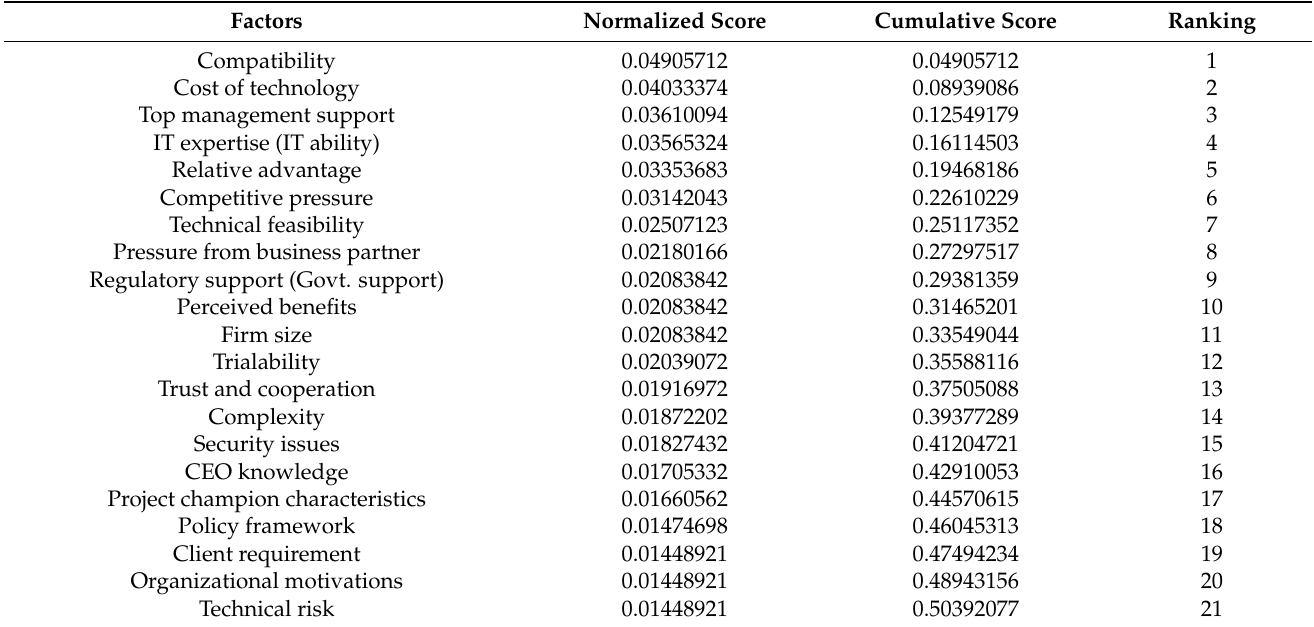
Table 4. Assessed factors affecting the adoption of collaboration